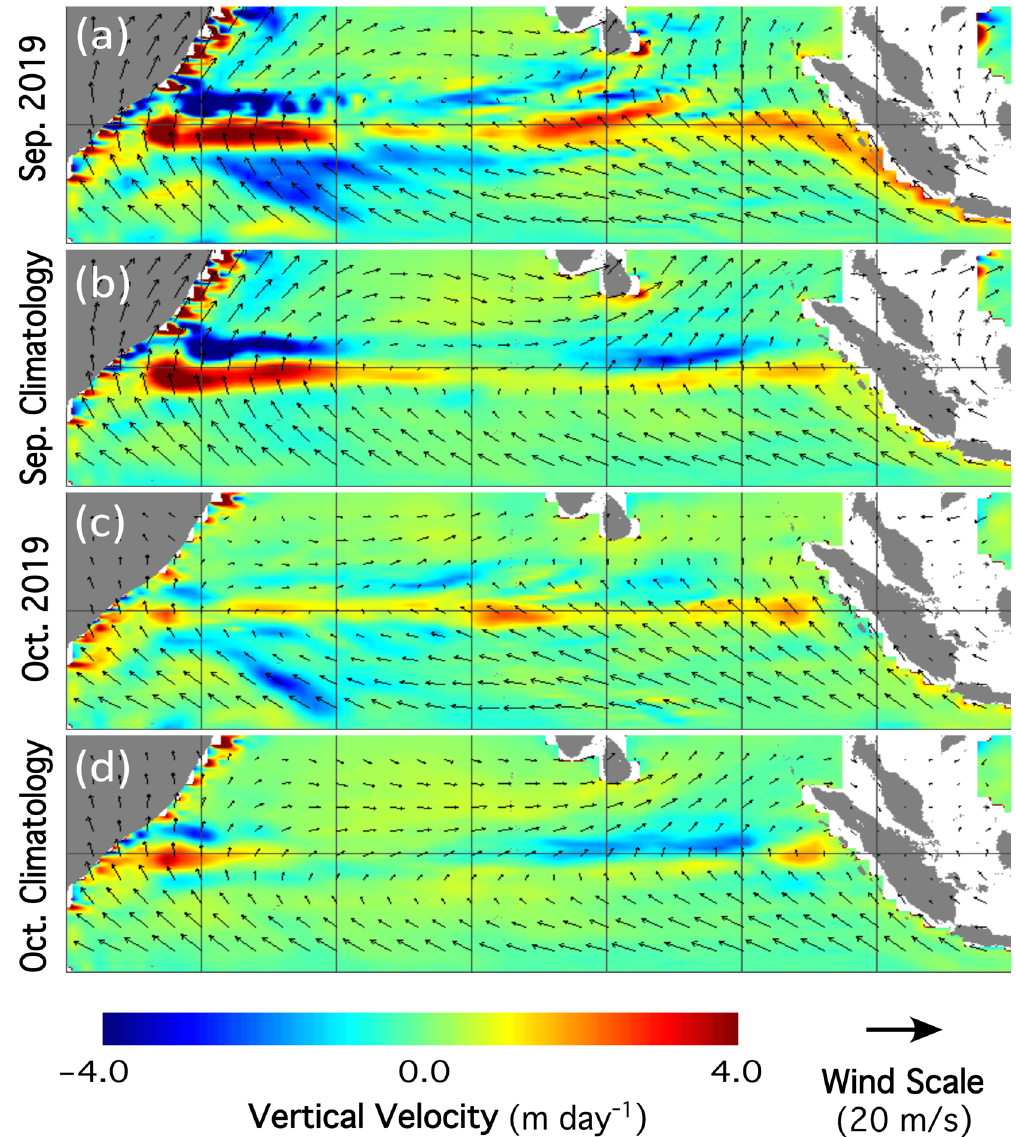
October 2019, and ( d ) climatology vertical velocity in